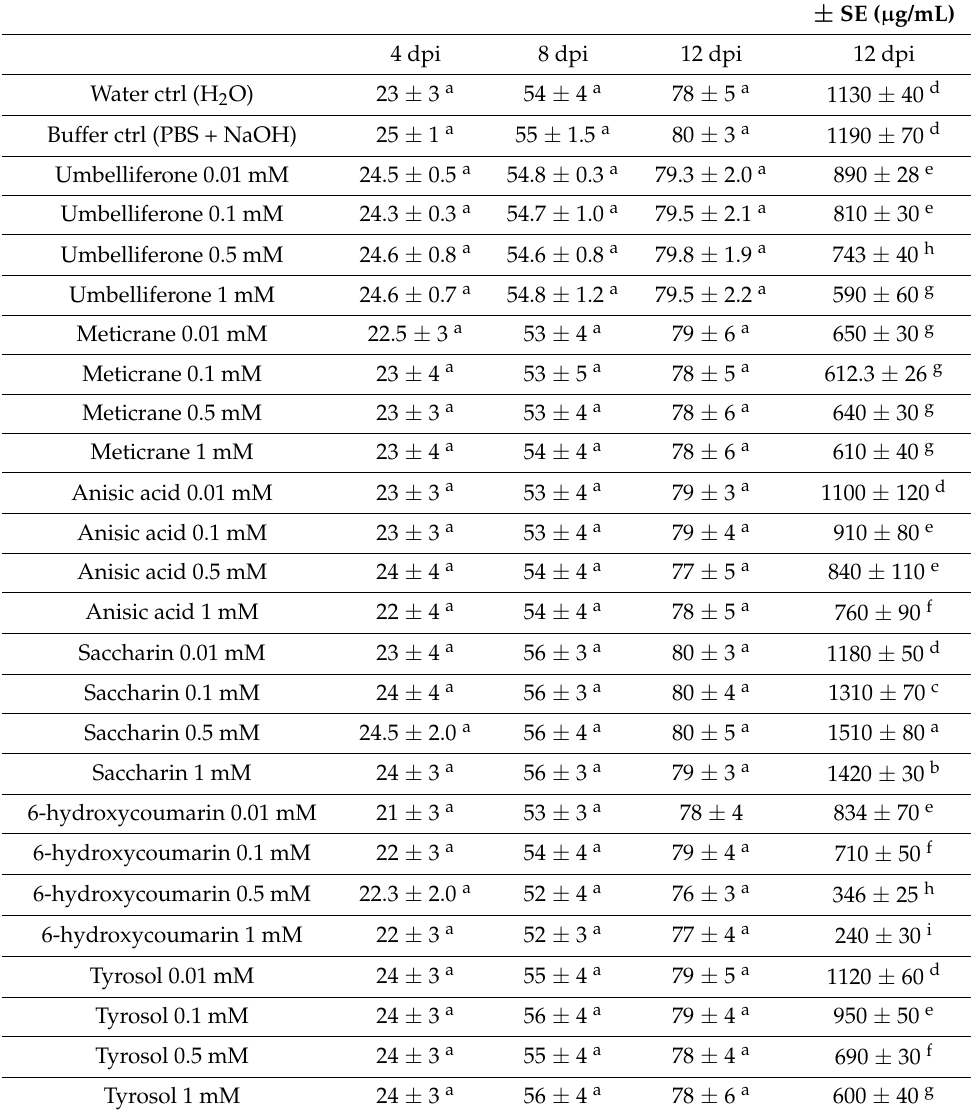
Table 2. In vitro colony growth (estimated as radial growth, mm) and patulin production ( µ g/mL) after 12 days post inoculation (dpi). Mean values and standard errors (SE) of at least three replicates are reported. Superscript letters (a–i) in each cell indicate whether the comparison (Tuckey test) between the corresponding pair of samples in a certain column returned a statistically significant difference ( p ≤ 0.05, different letters) or not (same